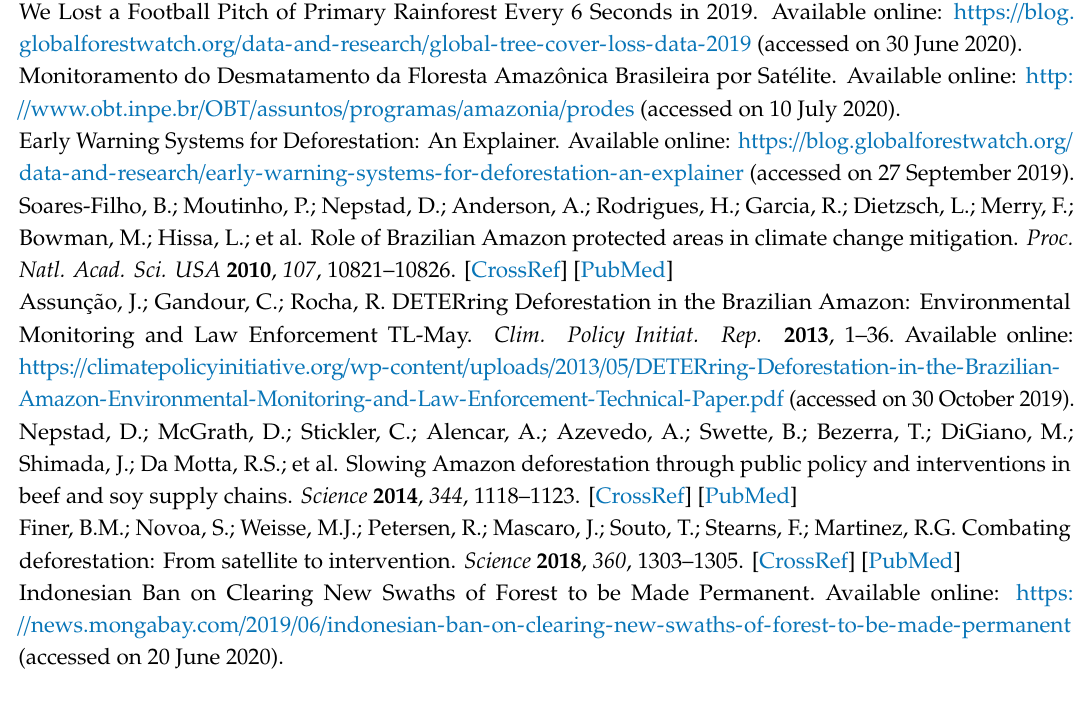
Table S1: Characteristics of the collected forest Time Series, Table S2: Characteristics of the collected deforestation Time Series, Figure S1: Box-plot of the coe ffi cient of variation of the forest speckle-filtered time series, Table S1: Mean reduction of the variability of the time series, Figure S2: Results of the Shapiro-Wilk normality test applied to the treated and non-treated forested TS, Table S4: Results of the Shapiro-Wilk test for normality of Forest time series, Table S5: Results of the Kolmogorov-Smirno ff test for gamma-distribution fitting of unfiltered Forest time series, Figure S3: Je ff ries-Matsushita distance of the F / DF classes as computed by the finite mixture algorithm, Figure S4: Density distribution of the values of the deforestation log-likelihood of the validation